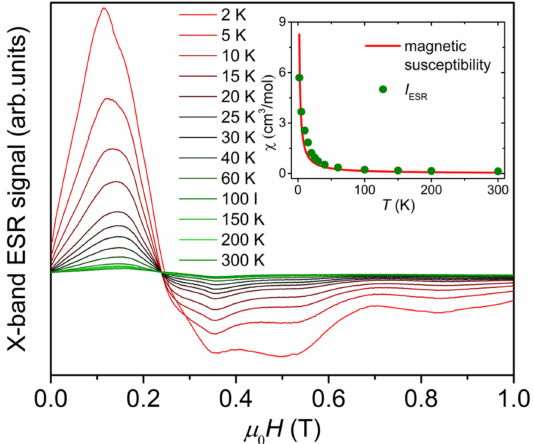
Figure 2. X-band ESR first-order differential signal spectra of {Cr 8 Y 8 } measured at 9.4 GHz within 2–300 K. The inset is the temperature dependence of the integral intensity of the spectrum ( I ESR , green dots), together with the magnetic susceptibility curve (red line) adapted from Reference